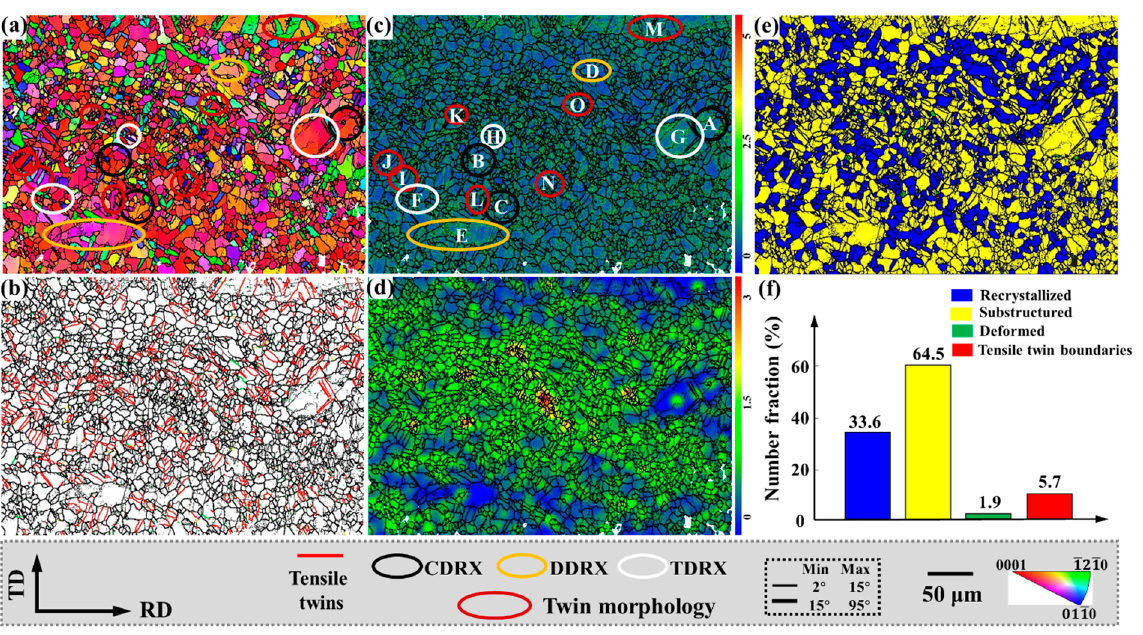
Figure 4. EBSD results of the sample after bending and straightening: ( a ) IPF, ( b ) tensile twin distribution, ( c ) the kernel average misorientation (KAM), ( d ) strain distribution, ( e ) the distribution, and ( f ) the content of different grains.